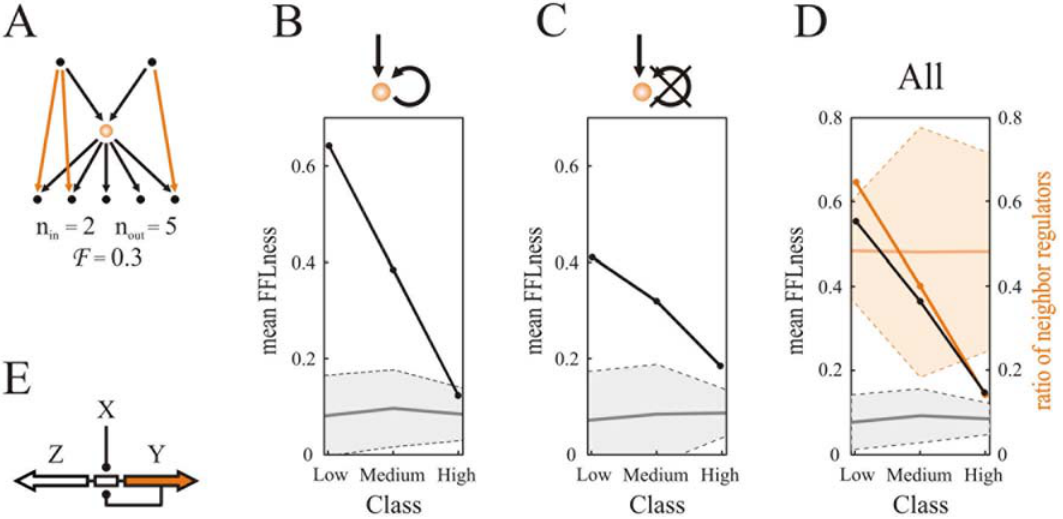
Figure 2. Assembly of FFLs and TF regulon size. (A) Computing FFLness: the maximum number of FFLs that can be potentially assembled by the TF in this example is n in n out =10. Imagine that only 3 FFLs were actually observed (orange arrows), then this TF would have F =0.3. (B–D) Mean FFLness as a function of regulon size for TFs with upstream control (classes defined as in Fig. 1). (B–C) autoregulated/non-autoregulated TFs. (D) all TFs with upstream control. The null behavior obtained in a network null model (Materials and methods; mean, continuous gray line, 6 2 standard deviations, shaded area) is also plotted. In (D) we additionally showed the ratio of TFs –with upstream control– regulating a neighbor operon (dark orange) and its corresponding null (mean, continuous light orange line, 6 2 standard deviations, orange-shaded area). Lines between points to help visualization. (E) Divergent architecture could promote FFL assembly. Spacer between two divergent operons ( Y and Z in FFL) could include a binding site leading to the coregulations of these operons by an upstream TF ( X ) and by the autoregulated TF ( Y ). Note how this genomic architecture links autoregulation to neighbor regulation [30,28,29,31].